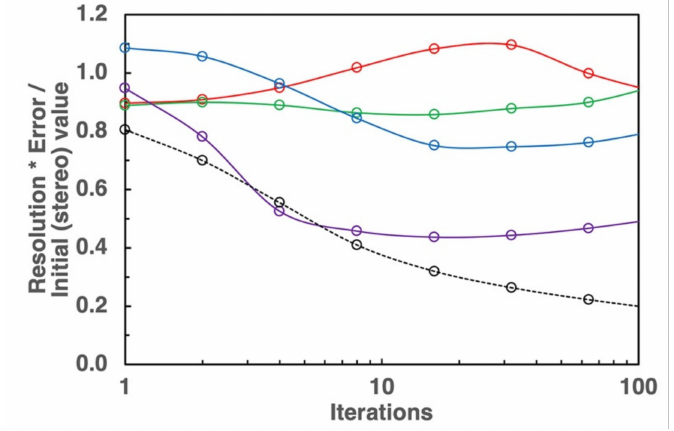
Figure 10. The product of resolution and error, normalized to its initial value for the stereo DTM, versus number of photoclinometry iteration steps. Colors correspond to subareas in Figure 3a; black curve is for synthetic data with no albedo variation over the entire DTM.